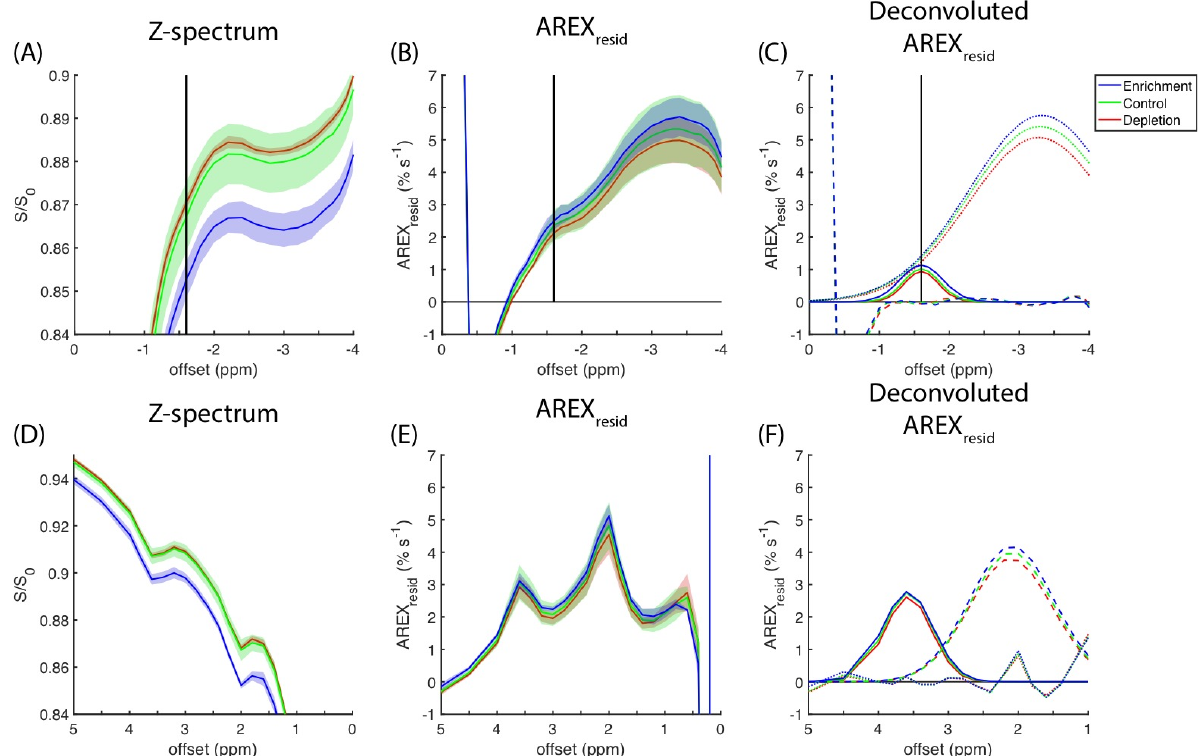
Figure 6. Averaged (N = 3) z ‐ spectra ( A , D ) from cholesterol ‐ depleted (red), control (green), and cholesterol ‐ enriched (blue) cell homogenates, corresponding AREX resid ( B , E ), and deconvoluted AREX resid ( C , F ). Standard deviations are indicated by shaded areas. Dotted lines indicate rNOE( − 3.5), solid lines indicate rNOE( − 1.6), and dashed lines indicate residues from deconvolutions. The CEST signals from the negative and positive regions are shown in ( A – C ) and ( D – F ), respectively.